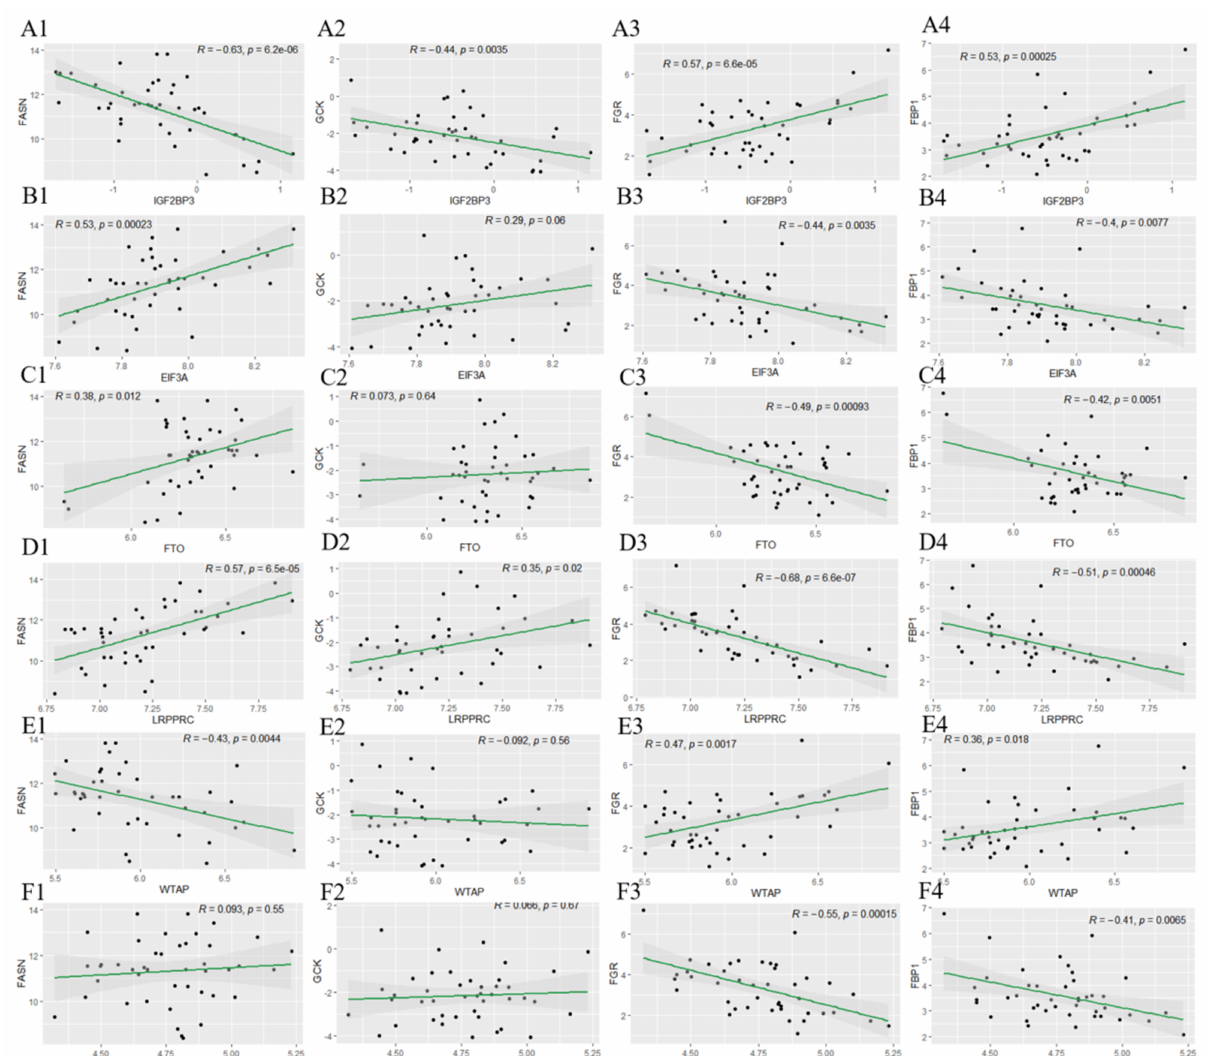
Figure 10. Correlations between FGR , FBP1 , FASN , and GCK expression and m 6 A modification. The relationships of FGR , FBP1 , FASN , and GCK expression with IGF2BP3 ( A1 – A4 ), EIF3A ( B1 – B4 ), FTO ( C1 – C4 ), LRPPRC ( D1 – D4 ), WTAP ( E1 – E4 ), and METTL14 ( F1 – F4 ) expression are